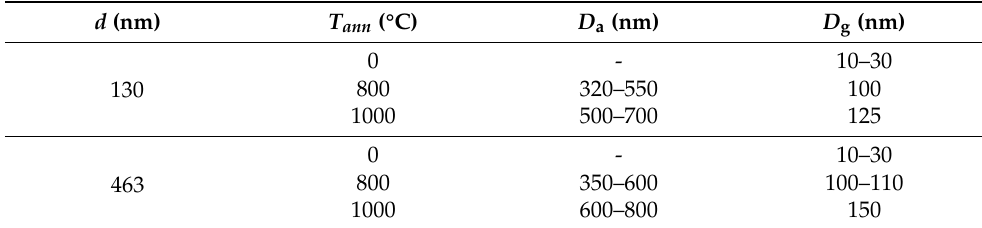
Figure 1. AFM images of TiO 2 thin films surface at d = 463 nm and T ann = 0 ( a ), T ann = 800 °C ( b ); T ann = 1000 °C ( c ). Table 2. Surface microrelief parameters of TiO 2 thin films.